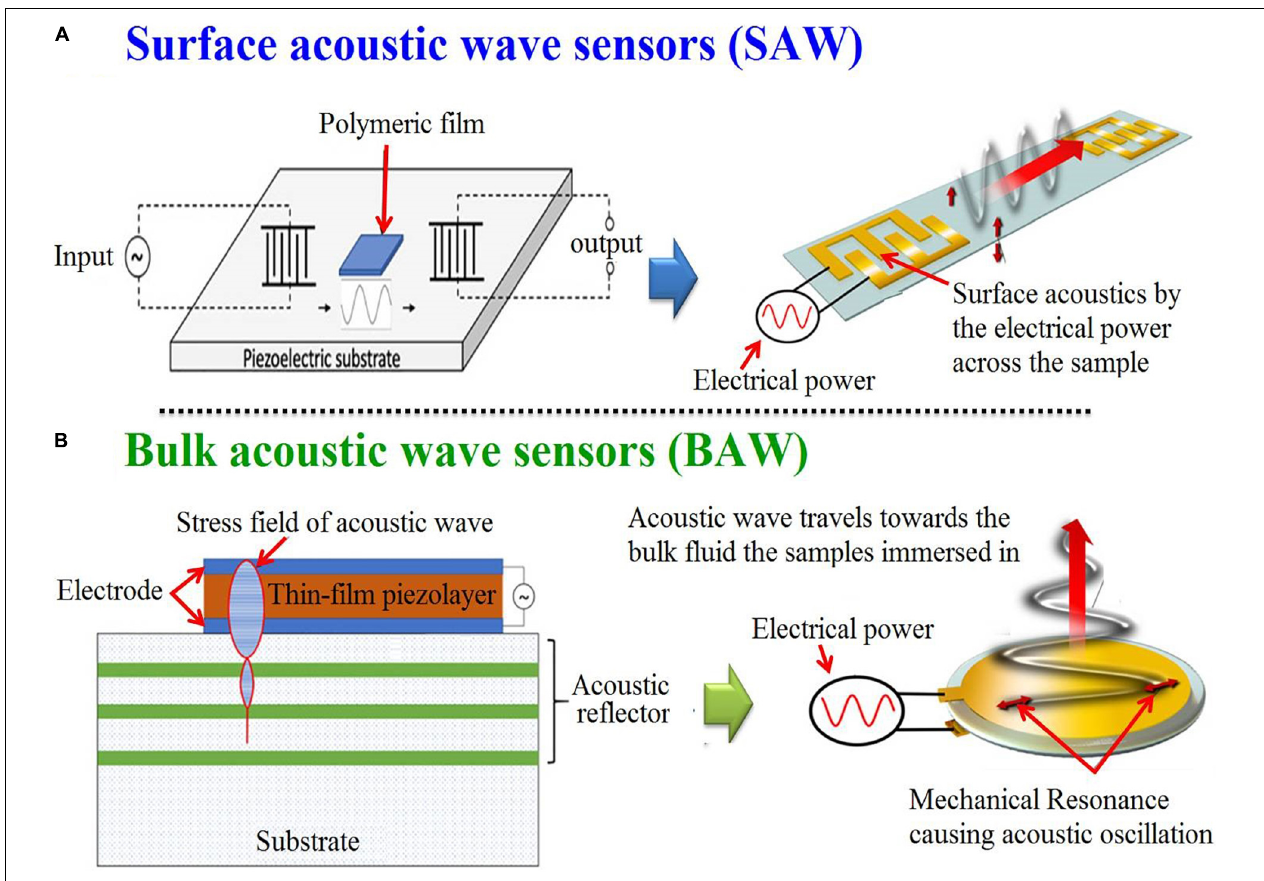
FIGURE 10 | Graphic depicting in general terms the processes for the generation of surface (A) and bulk (B) acoustic wave sensors (102) (Open access and no requirement of Copyright